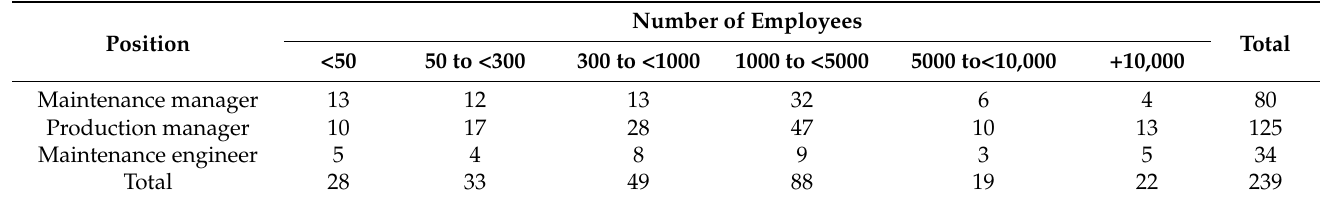
Table 1. Respondent corporate position vs. company size.